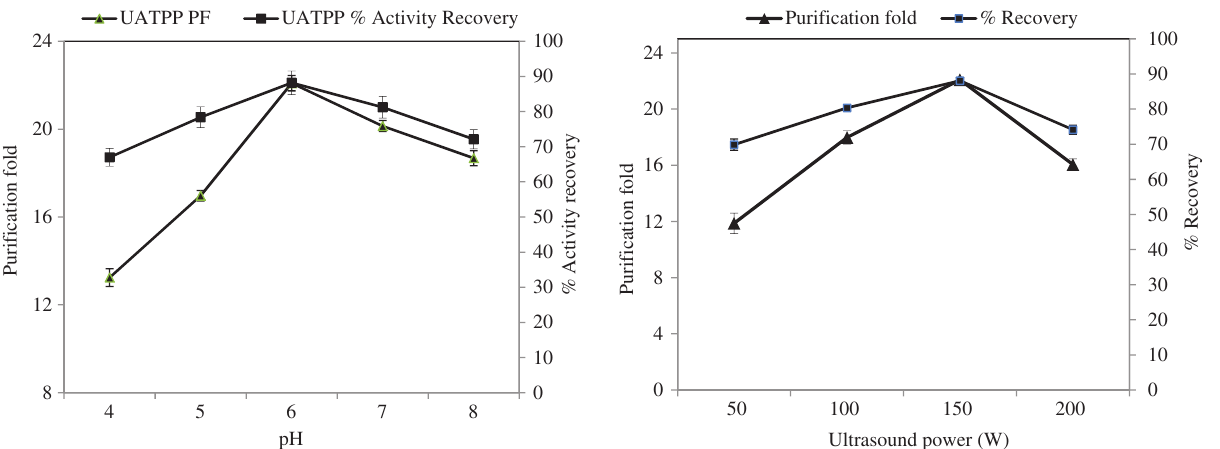
Figure 5: Effect of pH on ultrasound assisted three phase partition- ing (UATPP) of peroxidase.